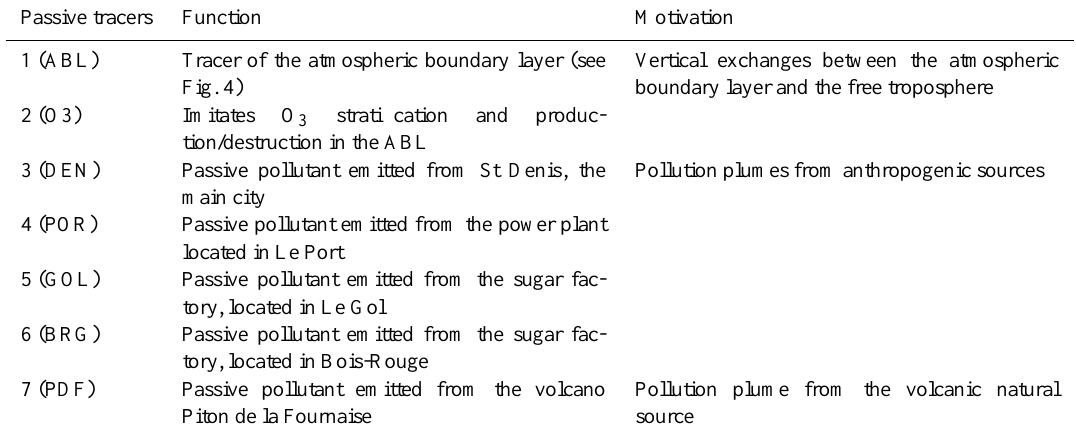
Table 3. Characteristics of passive tracers used in the simulations.